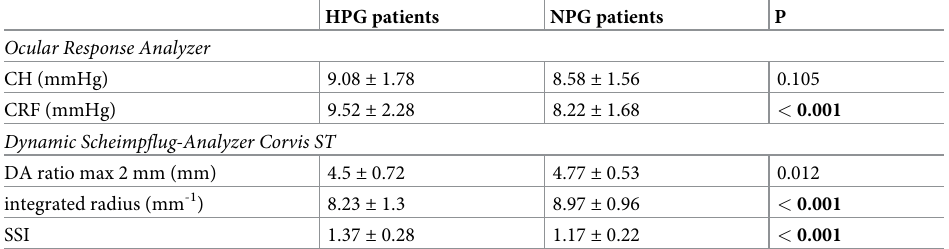
Table 2. Comparison of biomechanical parameters in high pressure (HPG) and normal pressure glaucoma (NPG) patients after group matching.